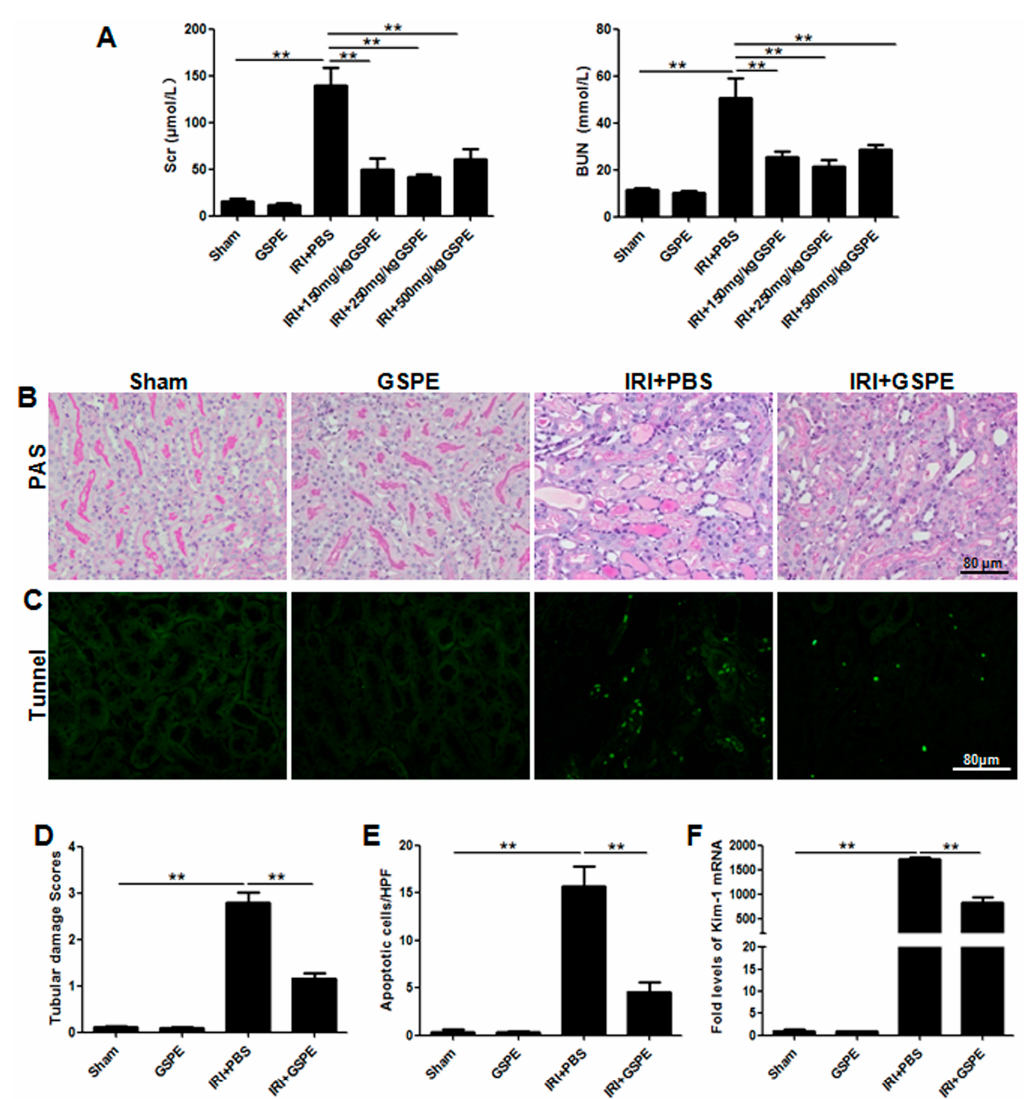
Figure 1. Administration of GSPE (grape seed proanthocyanindin extract) protects mice against bilateral IR-induced AKI (acute kidney injury). Mice pretreated with PBS or GSPE following bilateral IR or a sham operation served as controls. ( A ) Serum creatinine (Cr) and blood urea nitrogen (BUN) levels of the six groups; ( B ) PAS staining, showing pathological changes in each group; ( C ) Apoptosis in the kidney was assessed by the TUNEL assay; ( D ) Semi-quantitative analysis of PAS staining for the severity of renal injury; ( E ) Semi-quantitative analysis of TUNEL-positive cells; ( F ) Real-time PCR (Polymerase Chain Reaction) was used to measure mRNA expression of KIM-1. The data shown are mean ± SEM. (** p < 0.01; n = 7 per group).